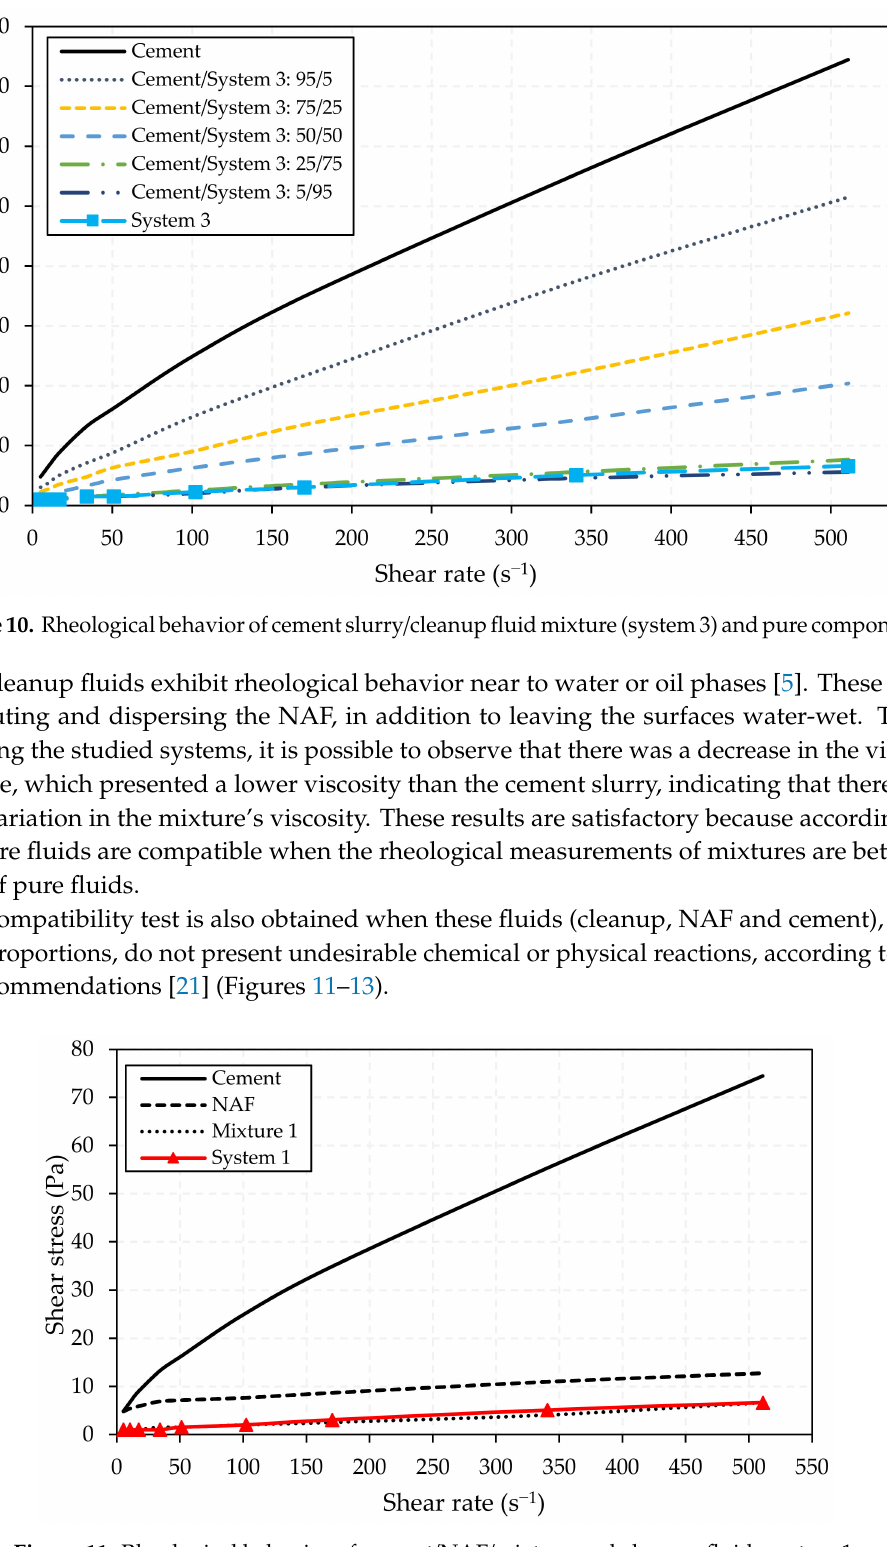
Figure 11. Rheological behavior of cement / NAF / mixture and cleanup fluid: system